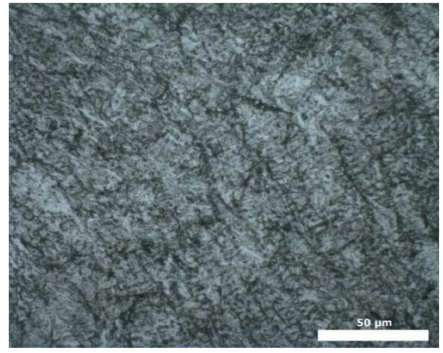
Figure 8. The microstructure of sample